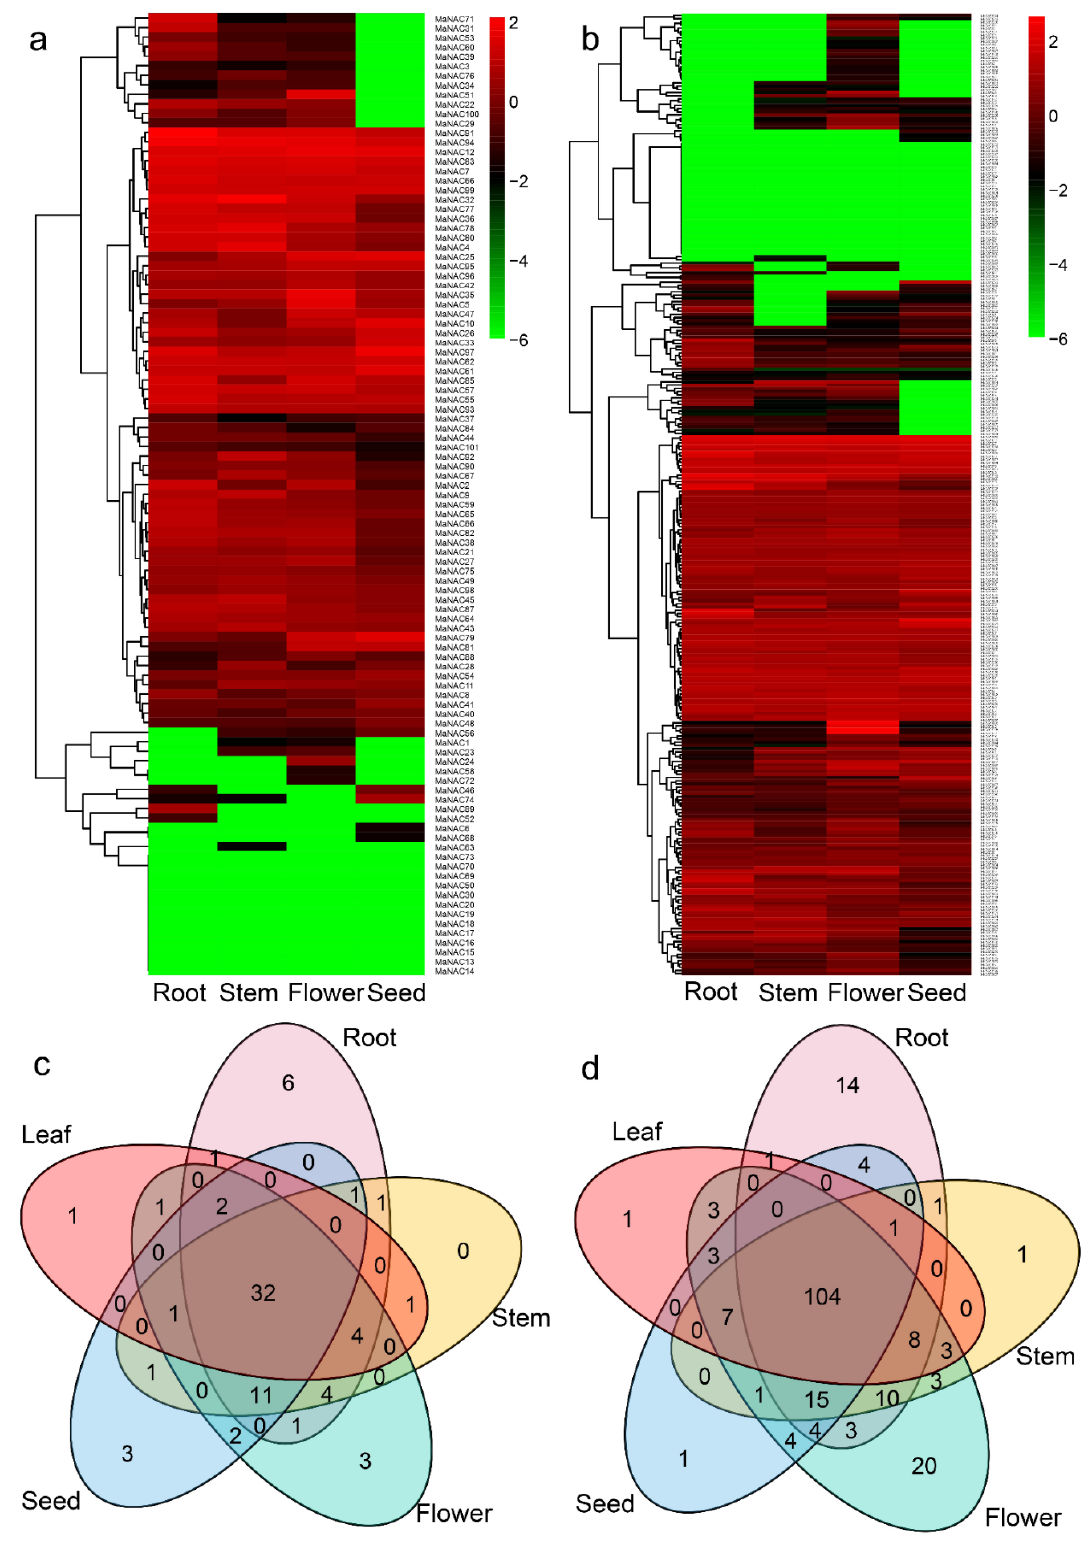
Figure 8. Expression profiles of MaNAC s and MaMYB s in the roots, stems, flowers and seeds. ( a ) Expression profiles of MaNAC s in the roots, stems, flowers and seeds. ( b ) Expression profiles of MaMYB s in the roots, stems, flowers and seeds. ( c ) The overlap of expressed MaNAC genes (FPKM > 0.5) in different tissues. ( d ) The overlap of expressed MaMYB genes (FPKM > 0.5) in different